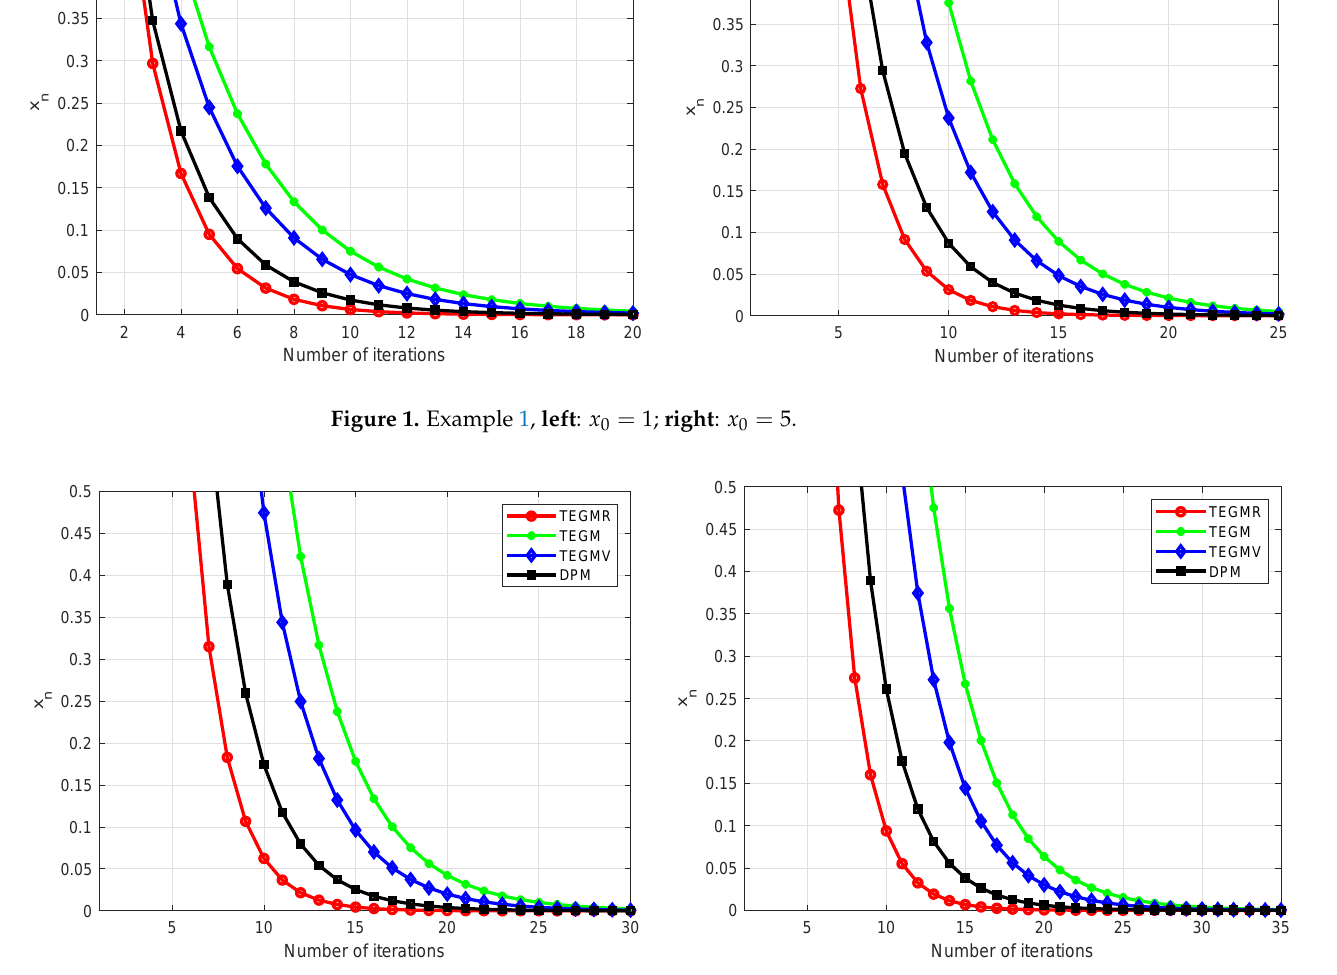
Figure 2. Example 1, left : x 0 = 10, right : x 0 =